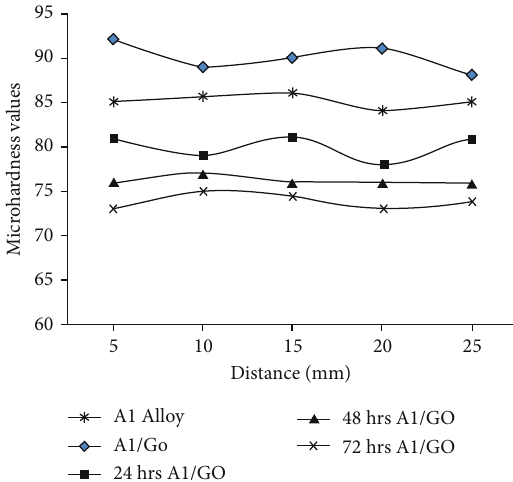
Figure 12: Microhardness values of the Al/GO composites.